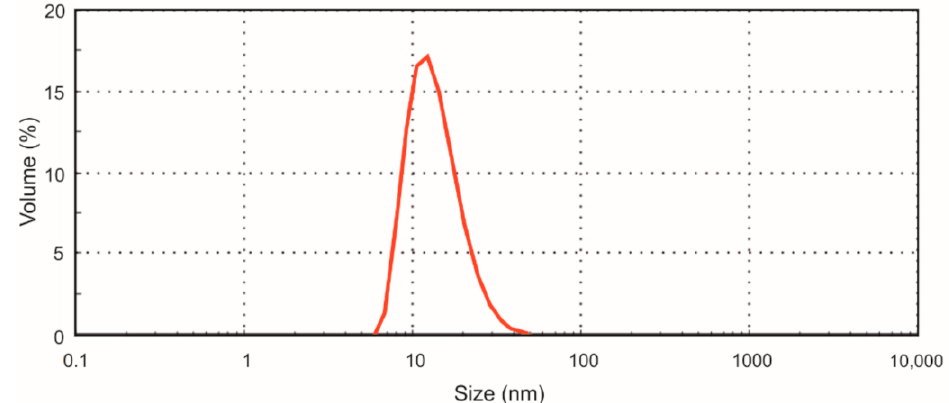
Figure 2. Size distribution of nisin-loaded iron oxide magnetic